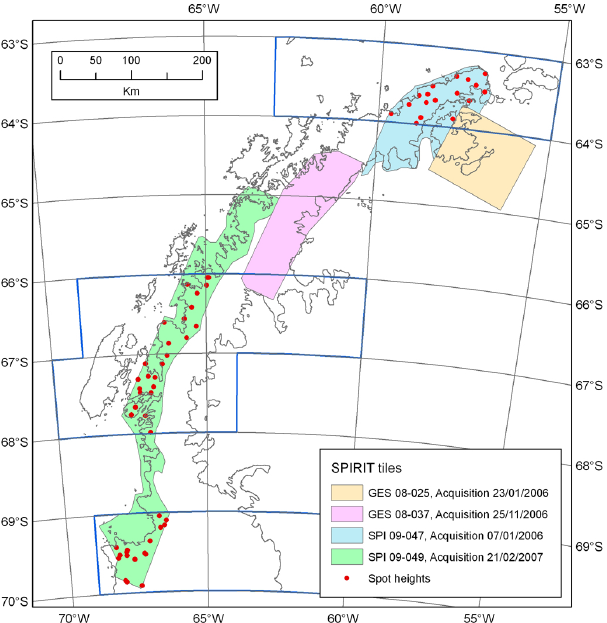
Figure 10. SPIRIT tile limits and their acquisition dates, plus the location of spot heights chosen for consistency and relative error